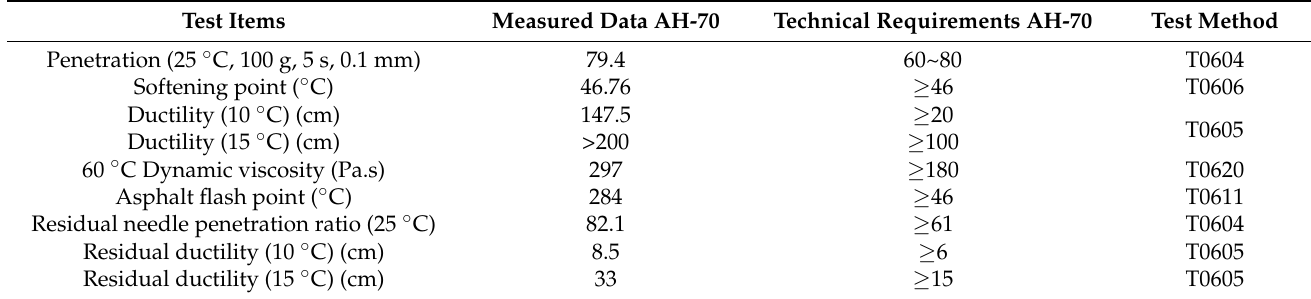
Table 2. Test results of asphalt raw